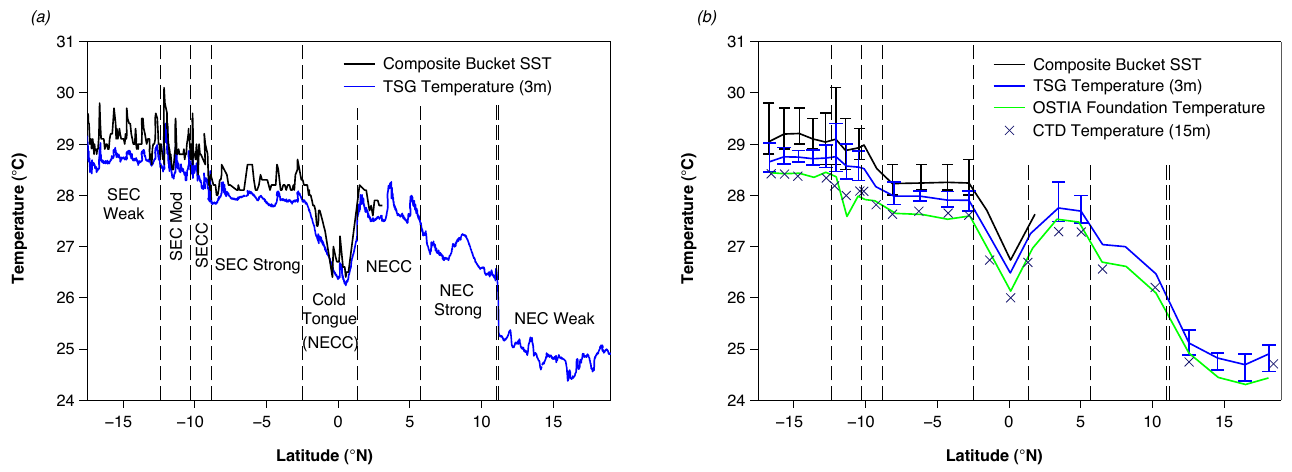
Fig. 5. Meridional temperature structure of the upper surface and near-surface along the cruise transect: (a) composite bucket SST and 3m thermosalinograph temperature, (b) daily average composite bucket SST, 3m thermosalinograph temperature, OSTIA foundation tempera- ture and 15m CTD temperature. The maximum and minimum values of composite bucket SST and 3m temperature on each local day are denoted by the upper and lower bars (not plotted in current regimes with strong meridional temperature gradients). Currents regimes are demarcated as in Fig. 4.